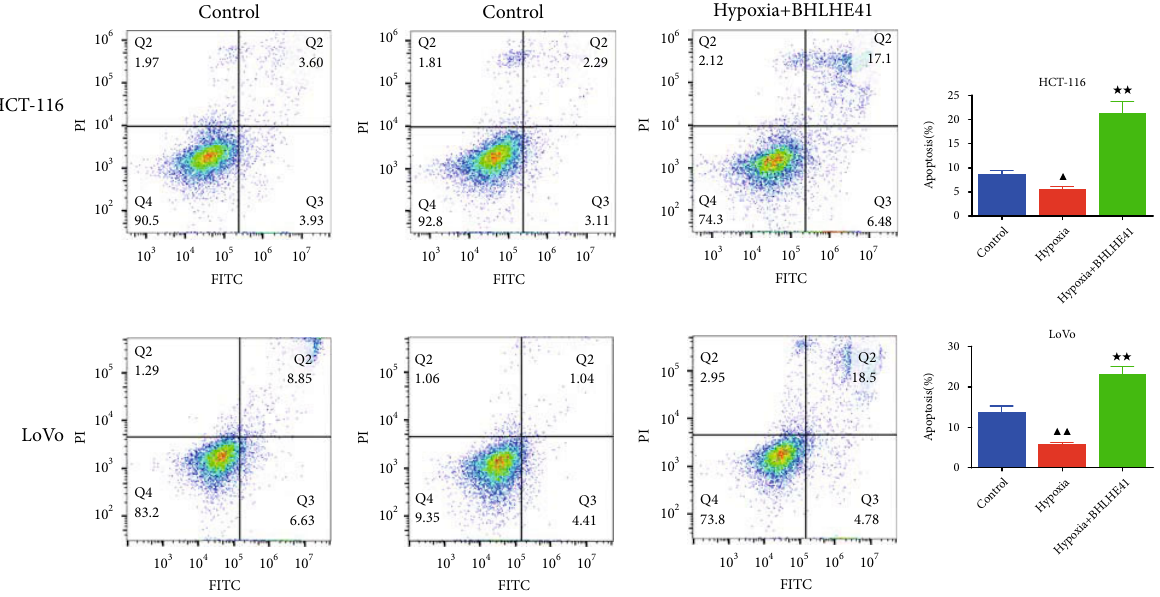
Figure 4: BHLHE41 overexpression induced apoptosis in hypoxia-induced CC cells. Apoptosis in hypoxia-induced CC cells was tested by fl ow cytometry. All experiments have been performed in triplicate, and data were expressed as mean ± SD . ∗∗ P < 0 : 01 vs. hypoxia; ▲▲ P < 0 : 01 vs. violet dye solution (C0121, Beyotime, China) for 30 min.